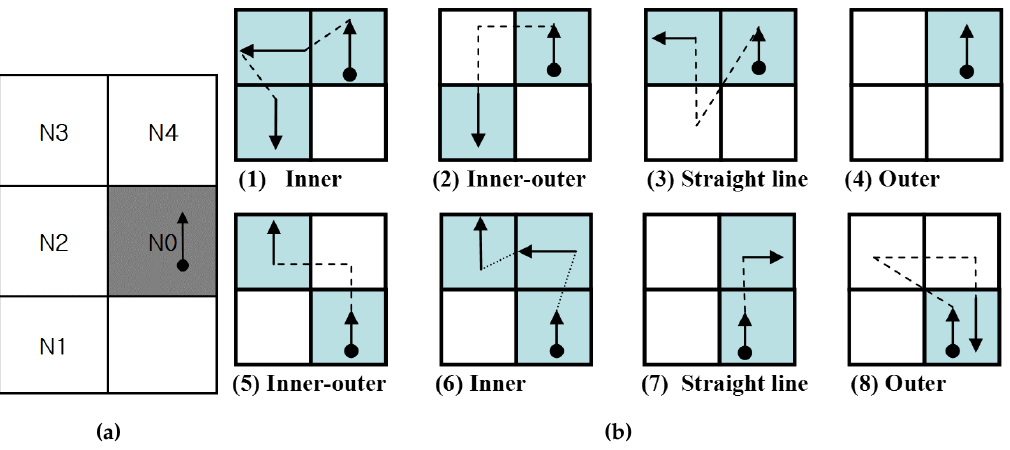
Figure 9. Contour tracing cases for the proposed contour-following algorithm. ( a ) Adjacent pixels; ( b ) contour